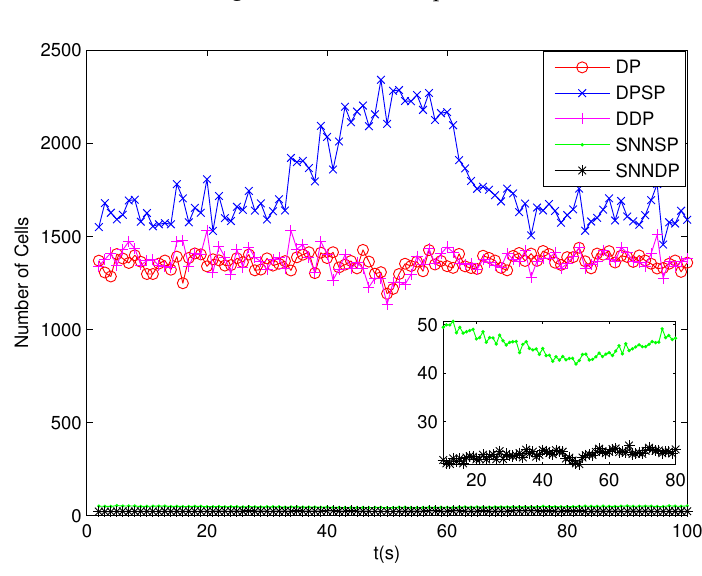
Figure 13. Number of partitions.